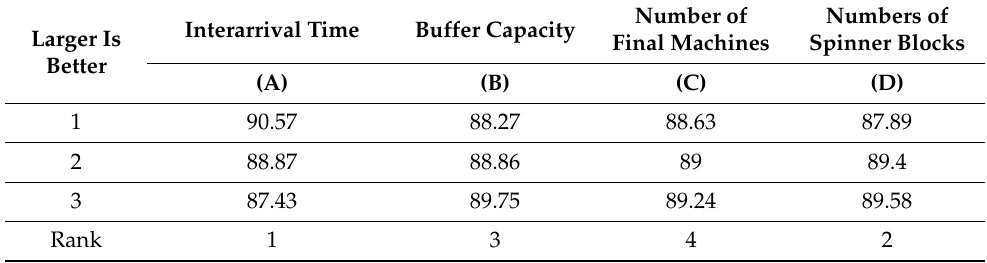
Table 8. Average n for each factor level.